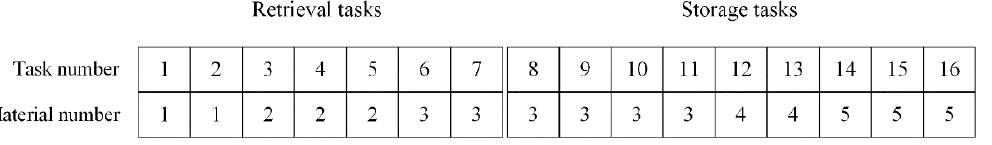
Figure 4. Mixed storage and retrieval tasks and material numbers.